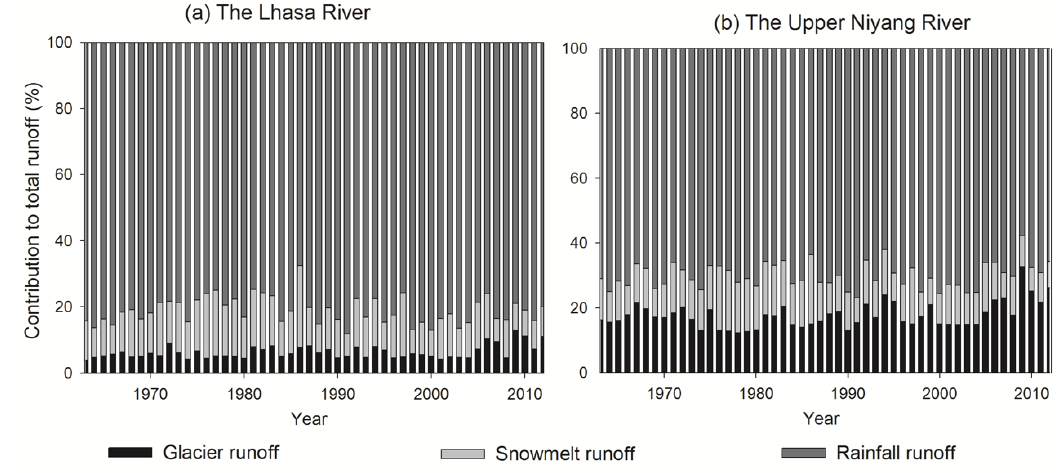
Figure 7. Annual contribution of glacier, snowmelt, and rainfall runoff to total runoff in the ( a ) LRB and ( b ) UNRB.